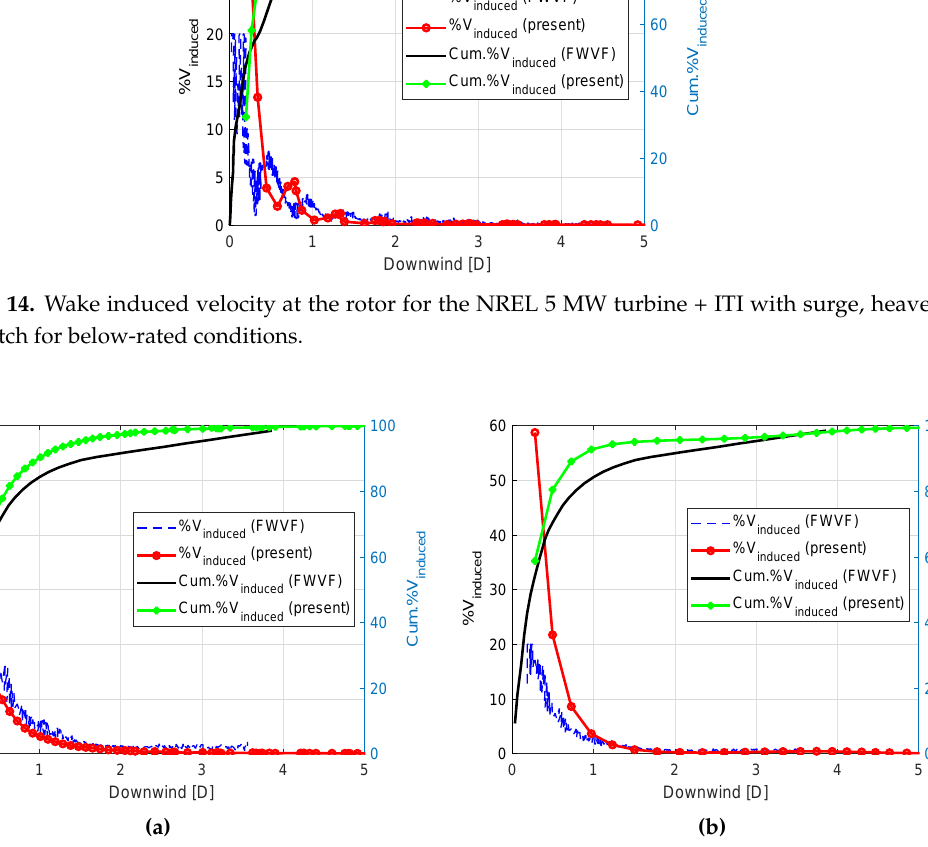
Figure 15. Wake induced velocity at the rotor for the NREL 5 MW turbine + OHS under pitch and yaw: ( a ) below-rated; and ( b )